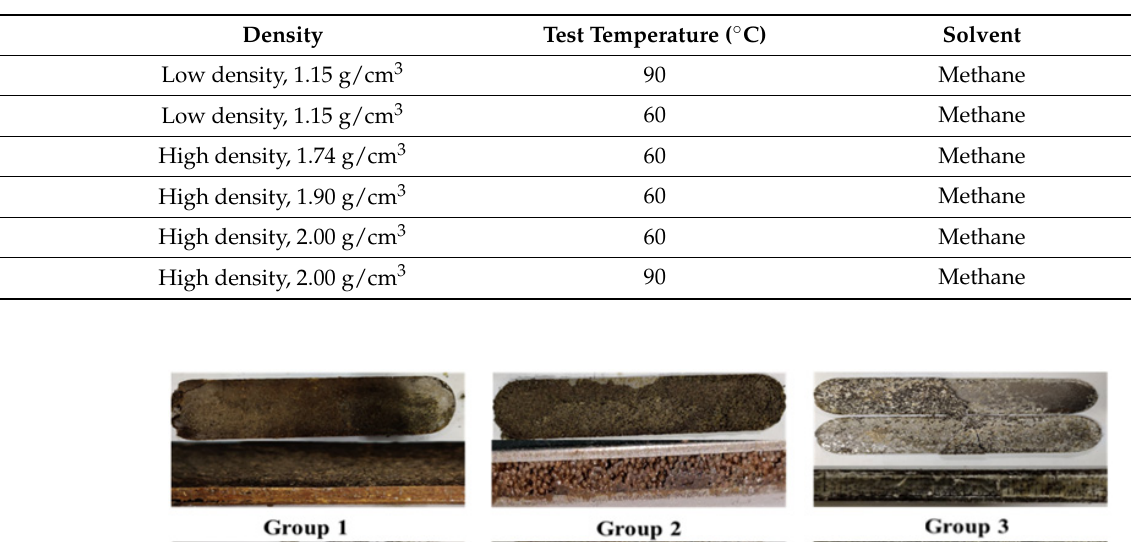
Table 3. Parameters in the gas solubility test.